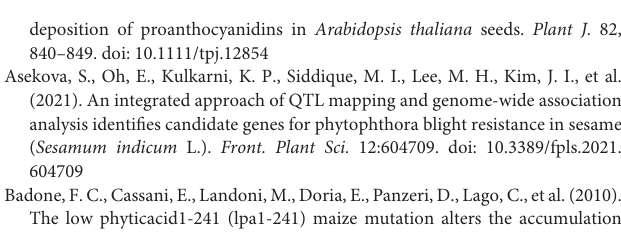
Supplementary Table 7 | Statistics of the RNA-seq datasets used in the study. Supplementary Table 8 | The DEGs identified between JS012 and Yuzhi 11 at the stages 5, 10, 15, 20, and 25 DAF, respectively. Supplementary Table 9 | The enriched KEGG pathways in the DEGs between JS012 and Yuzhi 11 at the stages 5, 10, 15, 20, and 25 DAF, respectively. Supplementary Table 10 | The DEGs in the qSC